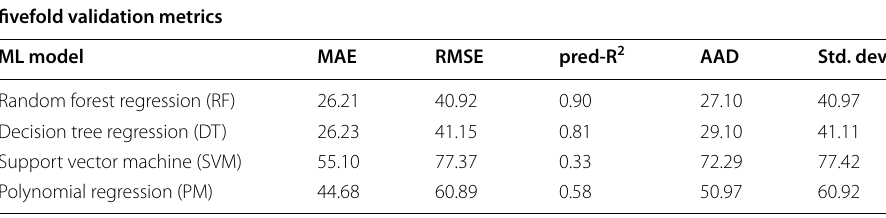
Table 3 ML model statistical evaluations using fivefold cross-validation fivefold validation